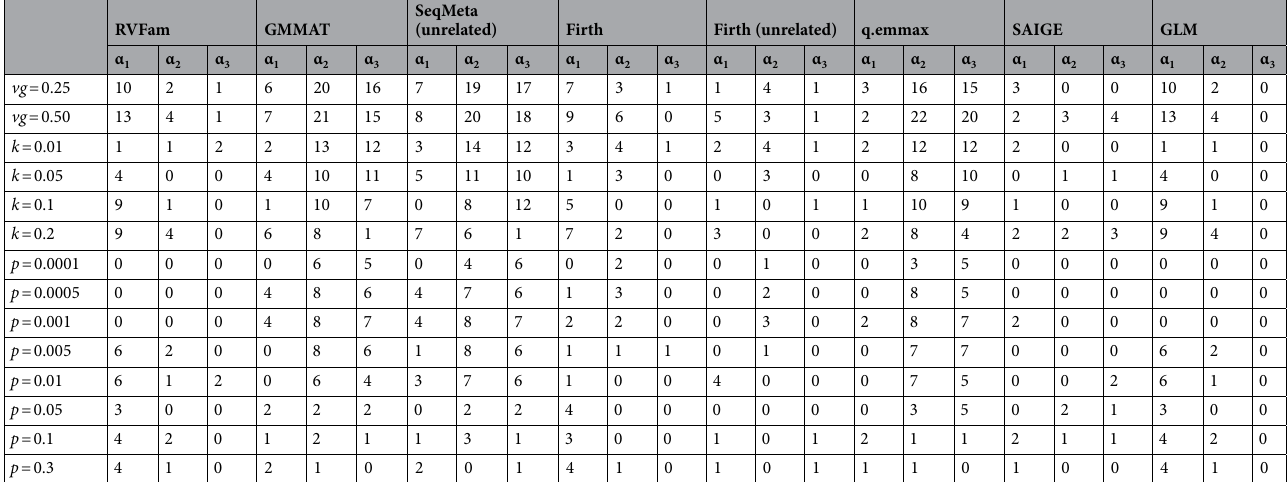
Table 4. Type I error results of the second simulation study. Level of significance is 0.05 (α 1 ), 0.001 (α 2 ) and 5E-6 (α 3 ). Numbers in the table indicate the number of scenarios with inflated type I error rates, i.e. false positive rates greater than level of significance inferred by a one-sided test. Methods with “unrelated” are those applied to unrelated samples, all other approaches were applied to related samples. We considered polygenic variance ( vg ) at 0.25 and 0.5, prevalence ( k ) at 0.01, 0.05, 0.1 and 0.2, and MAF ( p ) at 0.0001, 0.0005,